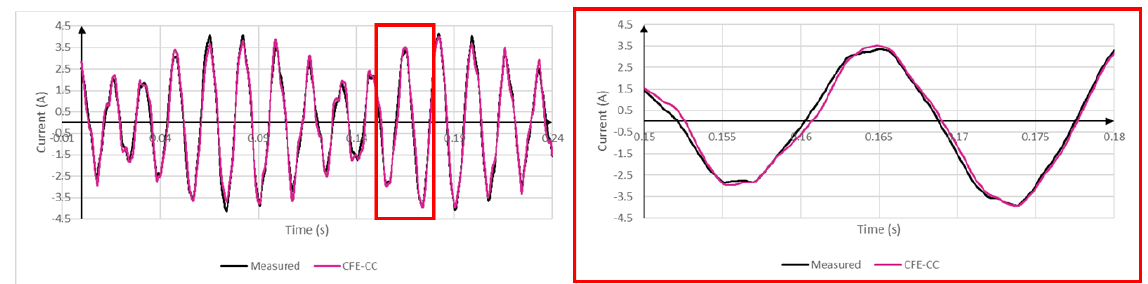
Figure 12. Stator current in winding a s during load operation with 12 ohm resistor on winding a r , enlarged on right